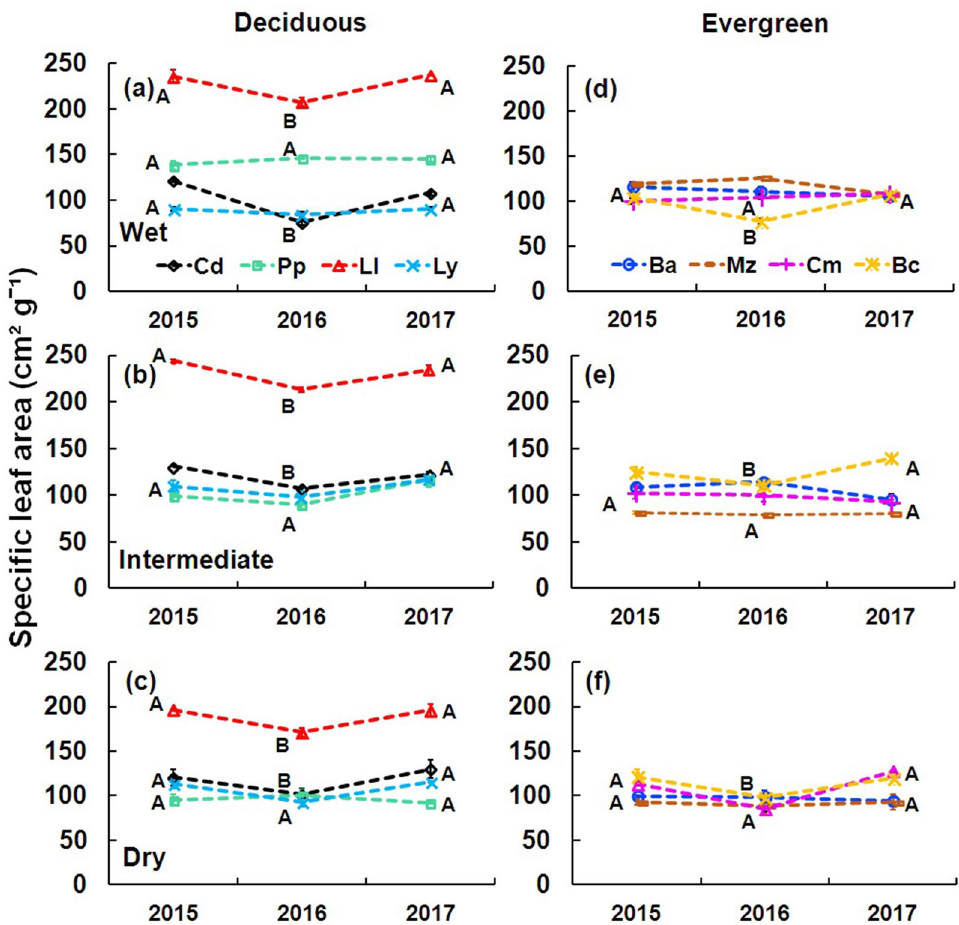
Figure 5. Specific leaf area for studied species in all sites from 2015 to 2017. Deciduous species ( a – c ): Cordia dodecandra (Cd), Piscidia piscipula (Pp), Leucaena leucocephala (Ll), Lysiloma latisiliquum (Ly). Evergreen species ( d – f ): Brosimum alicastrum (Ba), Manilkara zapota (Mz), Chrysophyllum mexicanum (Cm), Byrsonima crassifolia (Bc). Data are means ± SE. Capital letters next to species indicate significant differences among